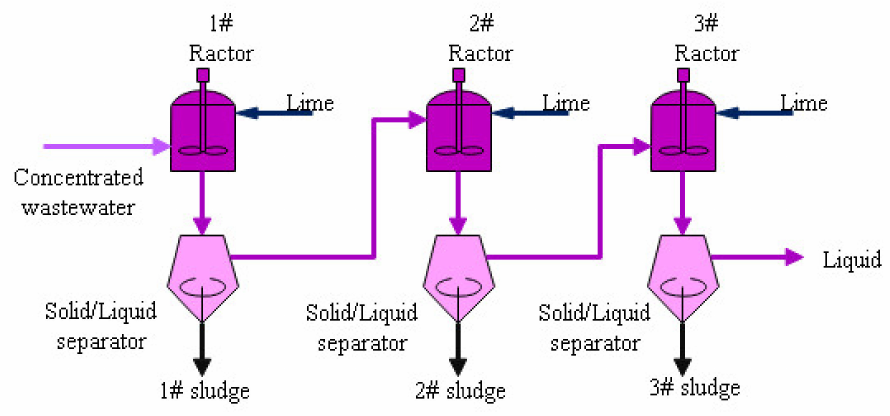
Figure 4. Scheme of small-scale test for the chemical dosing process. Lime is dosed into the reactor to react with the concentrated wastewater in three stages. For each stage, filter press was used to separate the solid and liquid in the